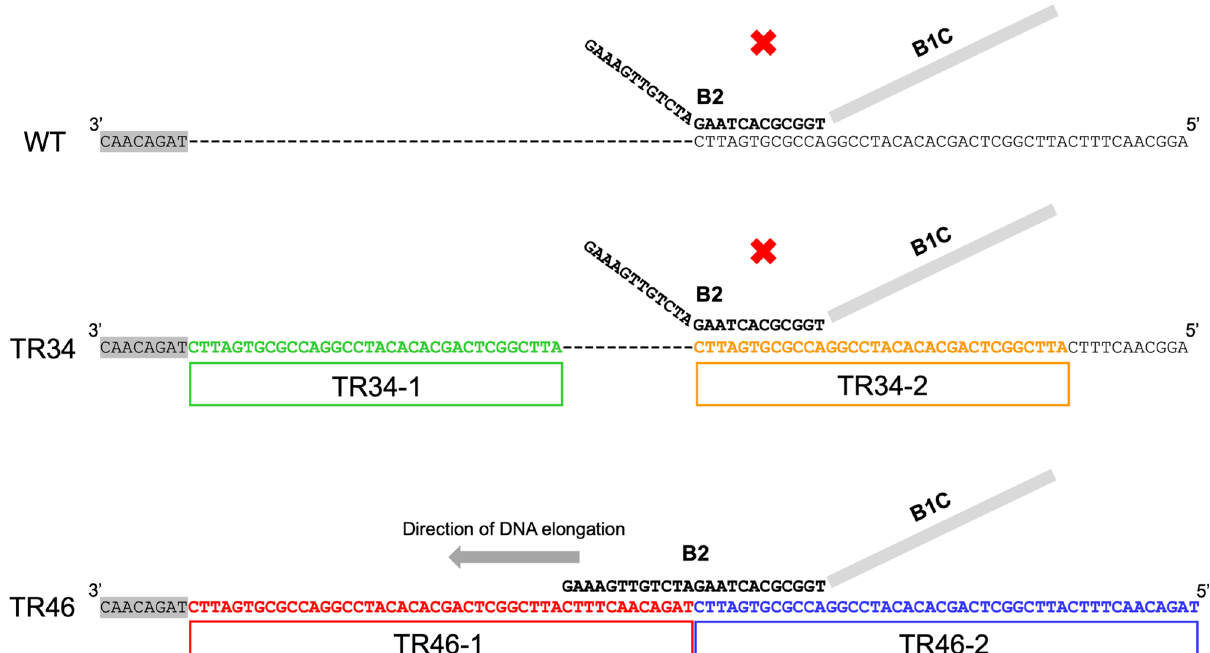
Figure 3. Schematic figure of TR 46 LAMP primer amplification site in comparison with those of wild type and TR 34 . The nucleotide sequence is targeted for the promoter region for the TR 46 resistance gene (between TR 46 -1 and TR 46 -2). The sequence in this part corresponds to the B2 sequence in Table